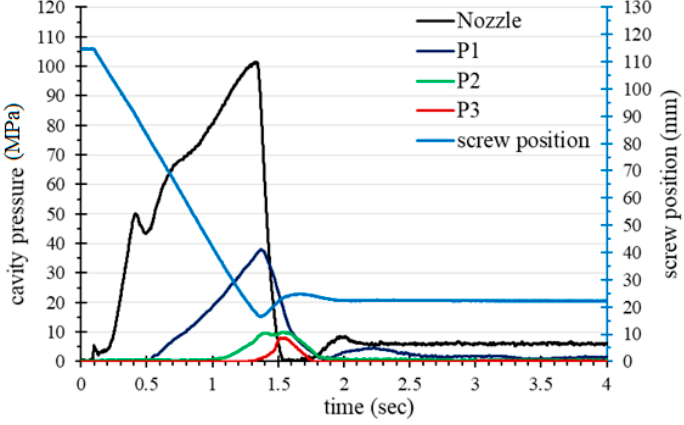
Figure 7. Cavity pressure profile and screw position with over-filling (no packing).